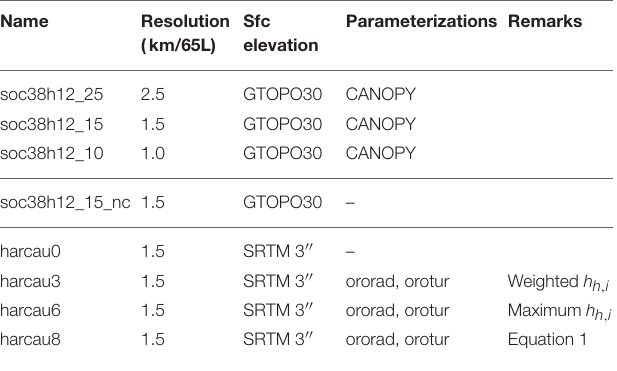
TABLE 2 | Three-dimensional HARMONIE